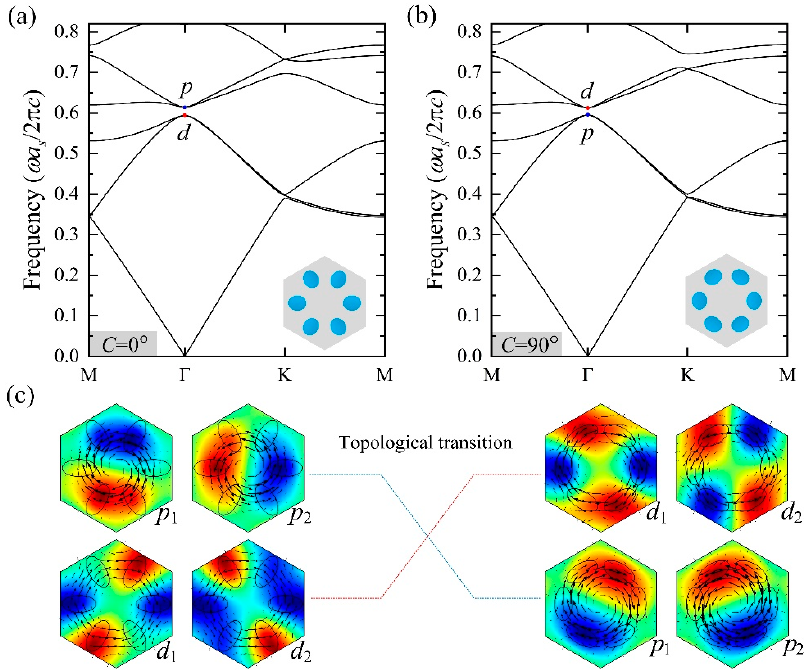
Figure 2. Band structures and topological modes inversion of the PCs. Corresponding unit cells are displayed at the bottom right corner in each subgraph. ( a ) The radical configuration with C = 0 ◦ leading to topologically nontrivial bandgap with p -type states having a higher frequency than the d -type states. ( b ) The azimuthal configuration with C = 90 ◦ , leading to topologically trivial bandgap with the p - and d -type states inverted. ( c ) The electric field distributions of the p / d eigenstates at the Γ point. The black arrows represent the time-averaged Poynting vector around the Γ point.